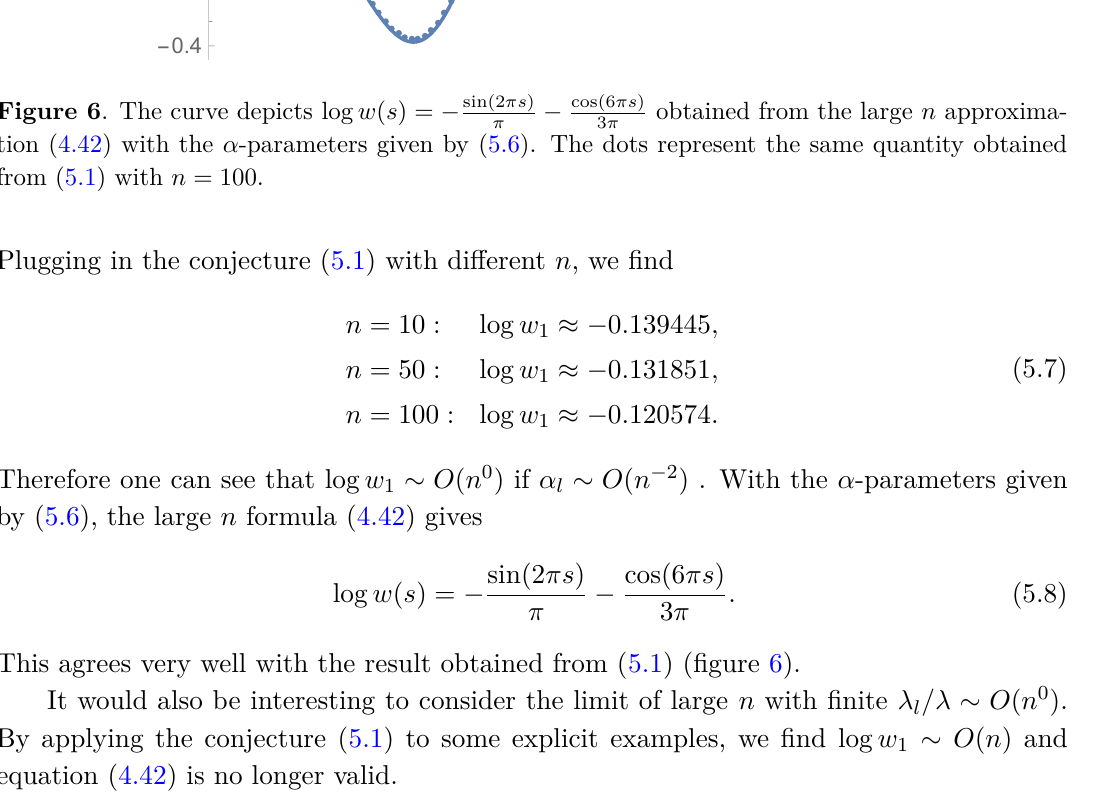
− cos(6 πs ) obtained from the large n approxima- π 3 π